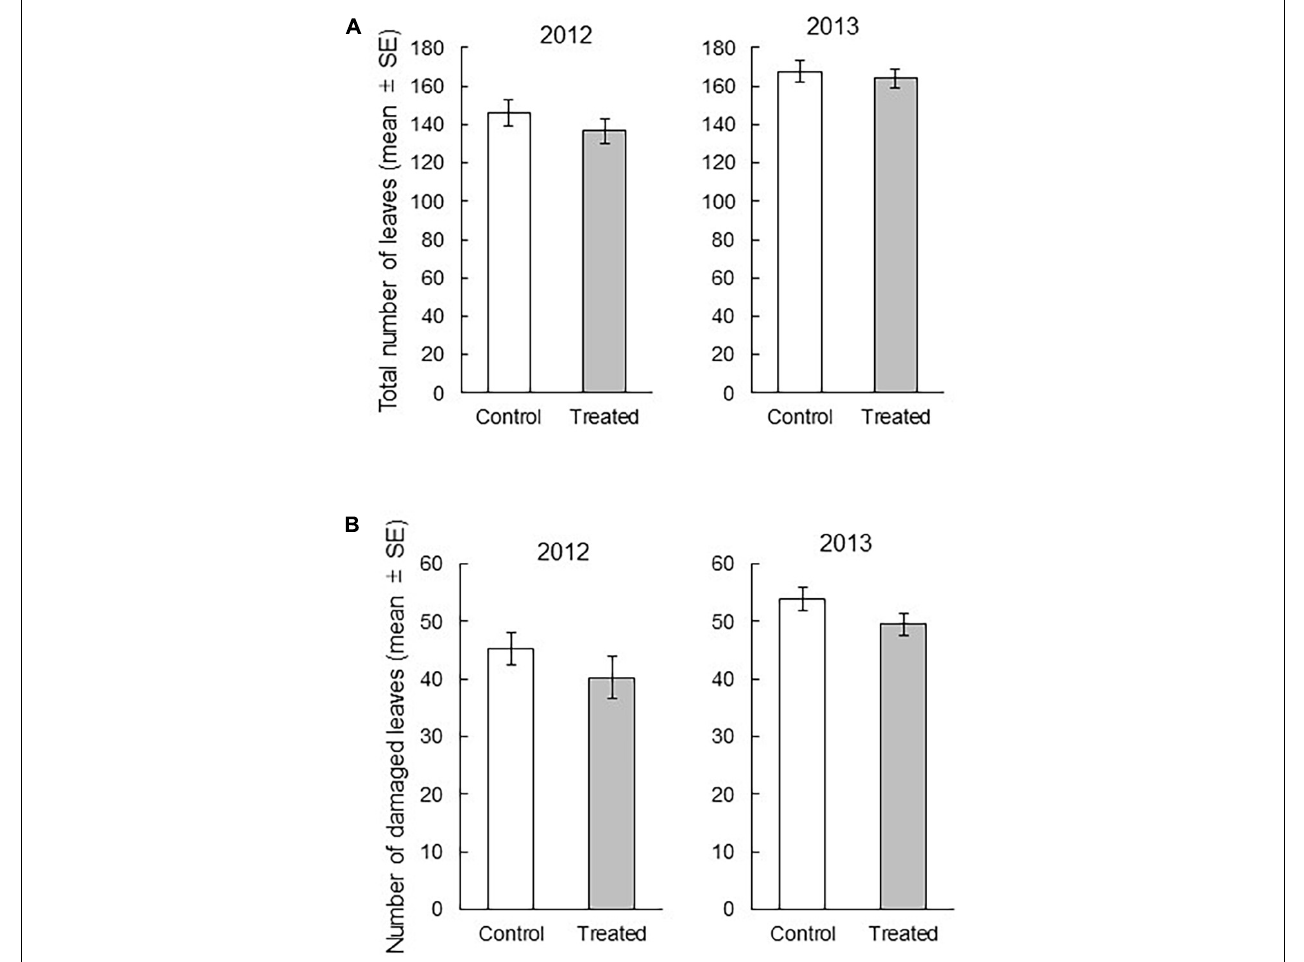
FIGURE 1 | (A) Comparison between the total number of leaves in a treated bunch and that in a control bunch (treatment P = 0.3147, year P = 0.0001, treatment × year P = 0.7884), and (B) the comparison between the total number of damaged leaves in a treated bunch and that in a control bunch (treatment P = 0.0468, year P = 0.0003, treatment × year P = 0.8564). The effects of treatment, year, and their interaction on the number of leaves were analyzed with the least square mixed model after Box-Cox transformation. N = 15, except for the data of one field in 2013 ( N = 14).